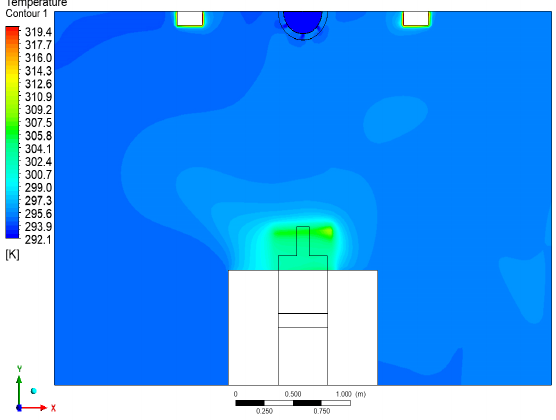
Energies 2022 , 15 , 3755 Figure 22. The temperature distribution of the Z = 2 m section. Figure 22. The temperature distribution of the Z = 2 m section. Figure 22. The temperature distribution of the Z = 2 m section.